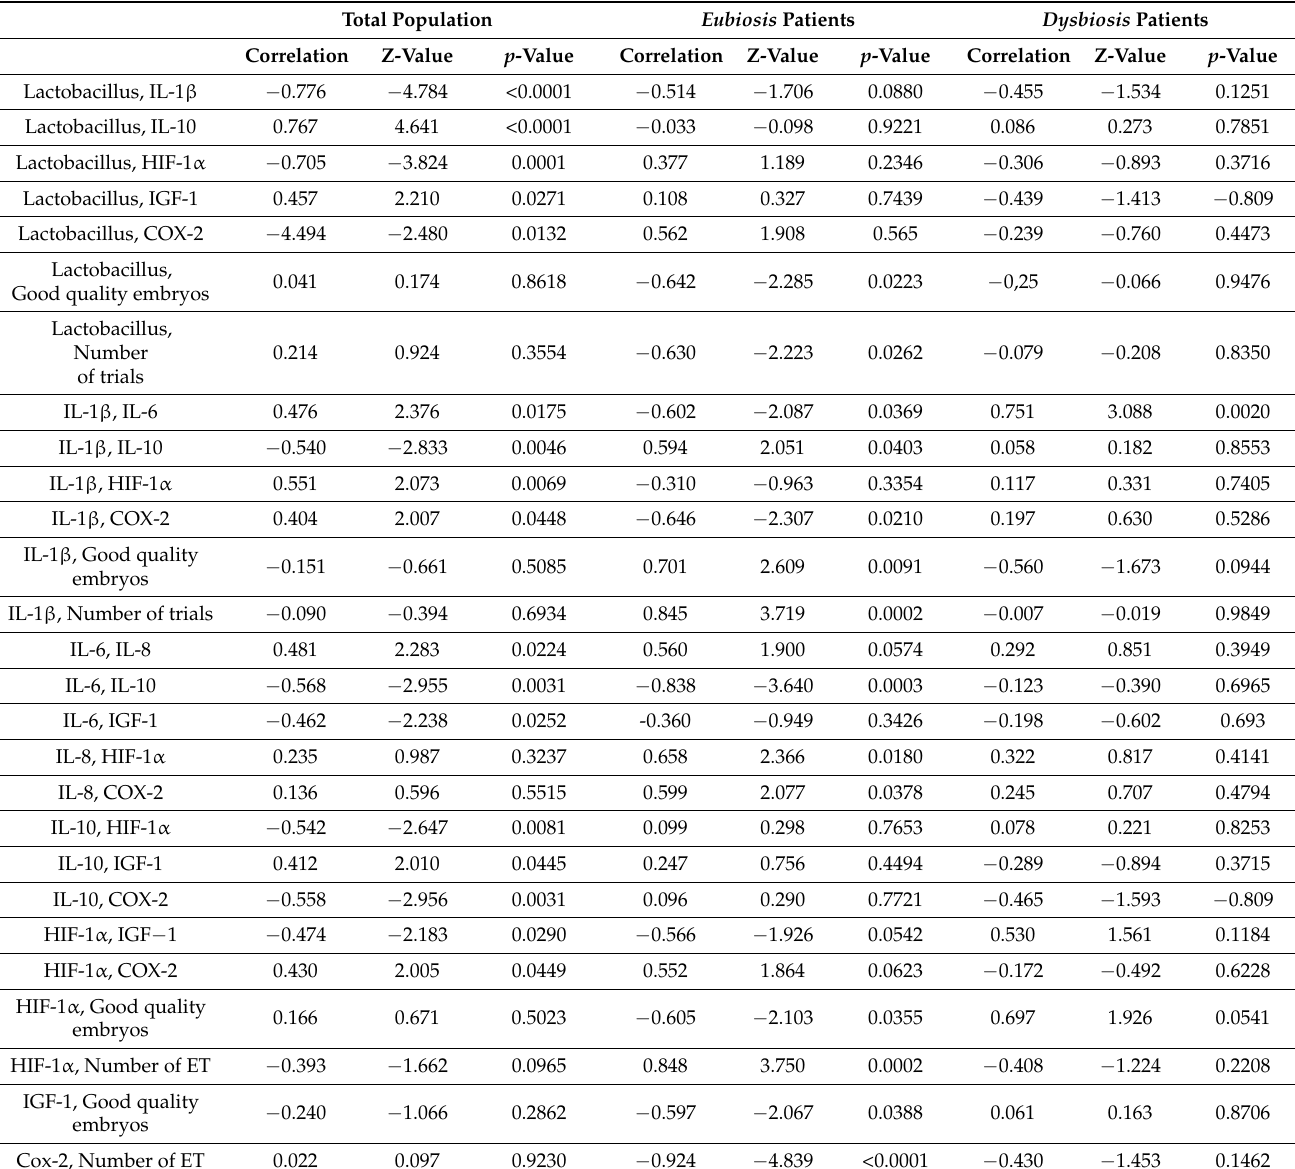
Table 5. Correlation between microbiota composition, biochemical markers and clinical parameters related to Total population, in eubiosis and dysbiosis subjects; Z and p values obtained for each correlation are reported in the respective column. ET,